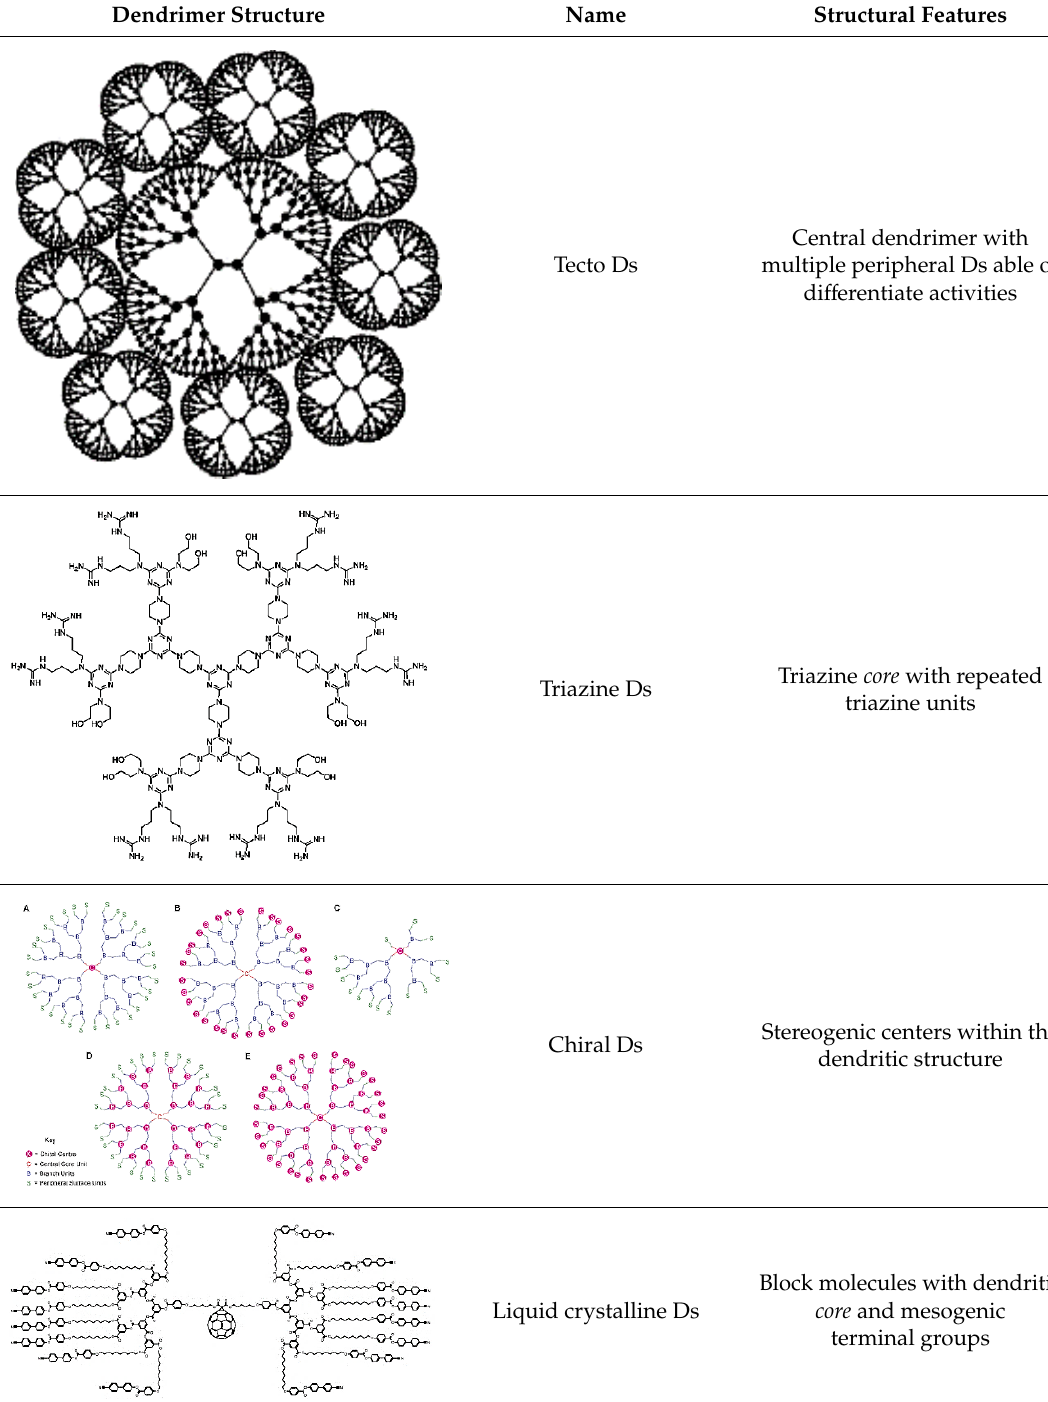
Table 2. Main types of dendrimer structures developed in the past 40 years.